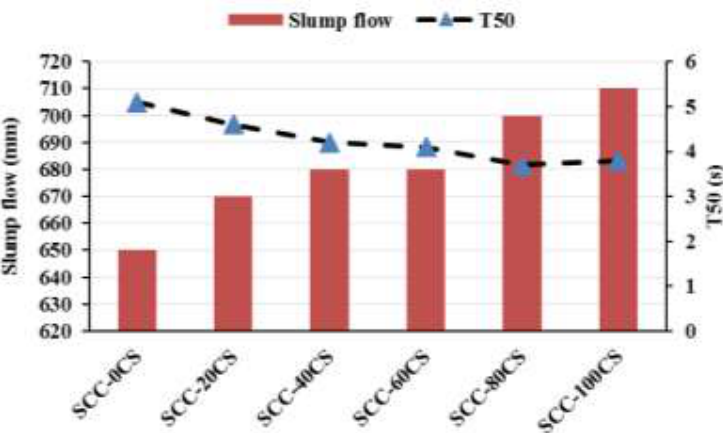
Figure 4 . Variation of Slump flow and T50 for different percentages of copper slag